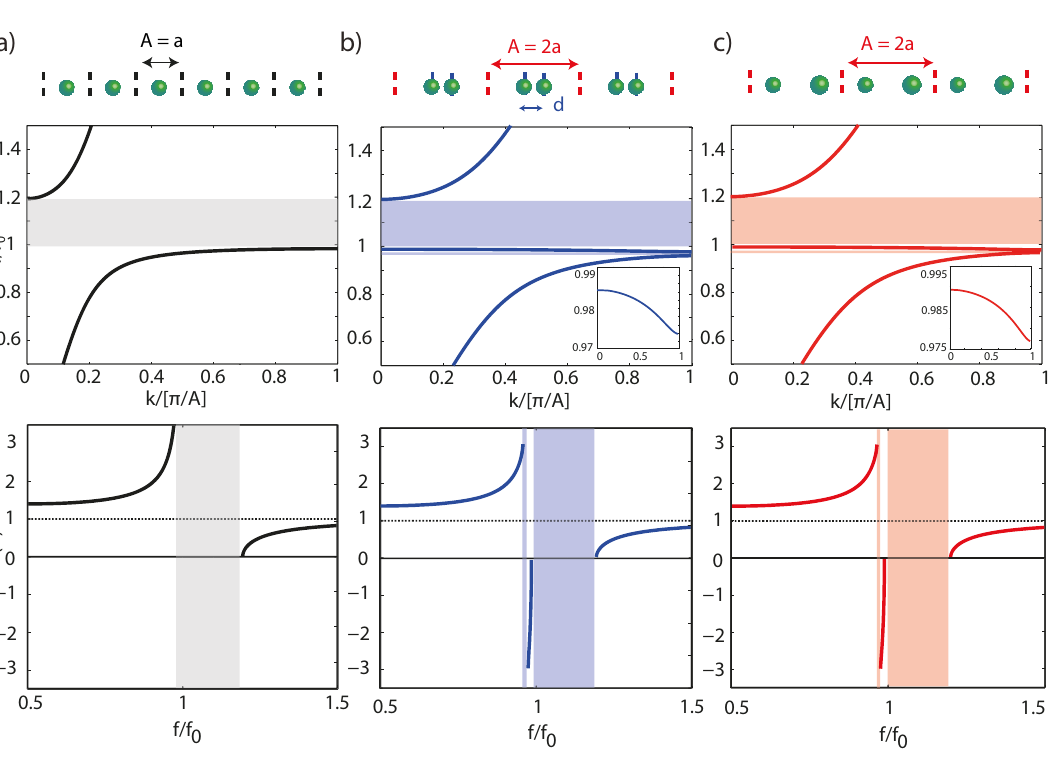
Figure 8. ( a ) Typical polaritonic dispersion relation for a periodic arrangement of resonant point scatterers (mathematical equivalent of the soda can) or its representation in terms of an effective index of refraction. By locally breaking the periodicity of the chain either by off-centering one resonator out of two ( b ) or by changing its resonant frequency ( c ) we end up on dispersion relations showing a negative band (the effective index of refraction is